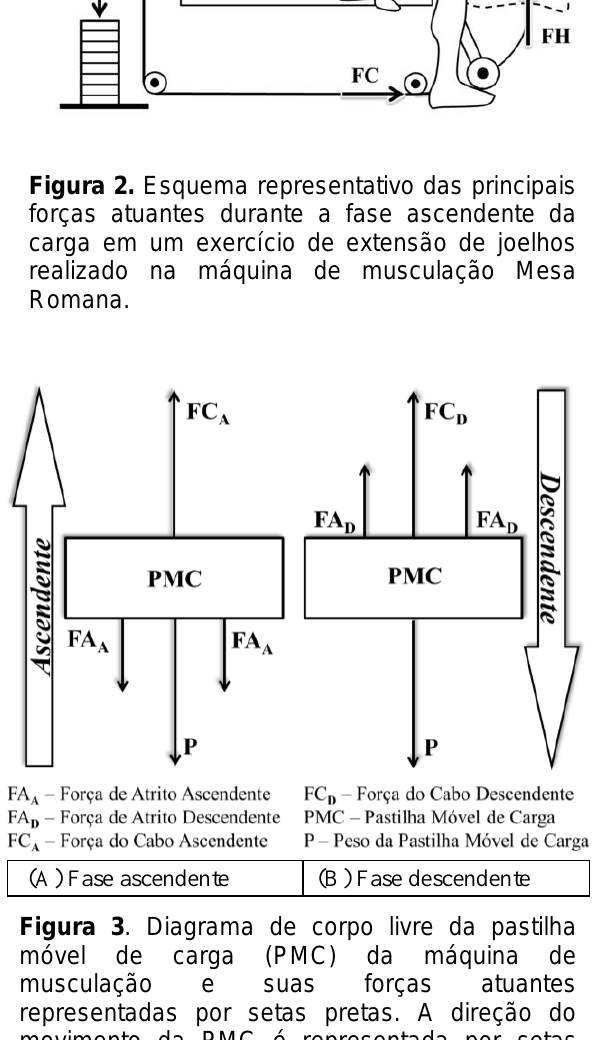
PMC durante esta fase do exercício (extensão